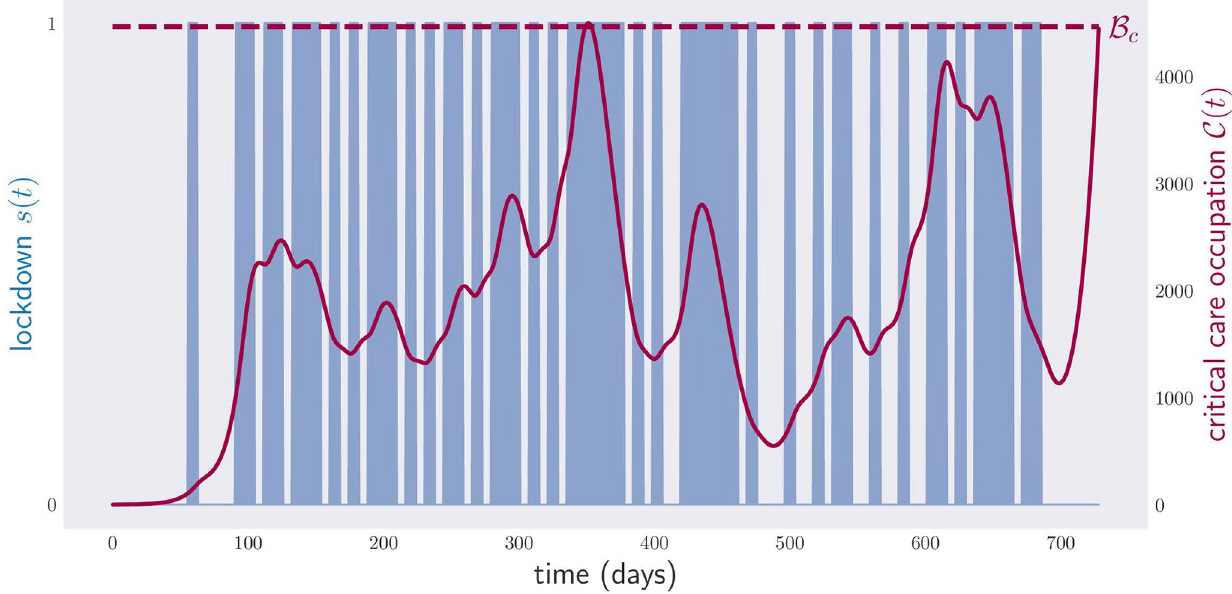
Fig 5. Occupation of critical care beds (red) and lockdown (blue) for a period of two years. The plot shows the result of the optimization over probabilistic policies via gradient descent over a period of two years.